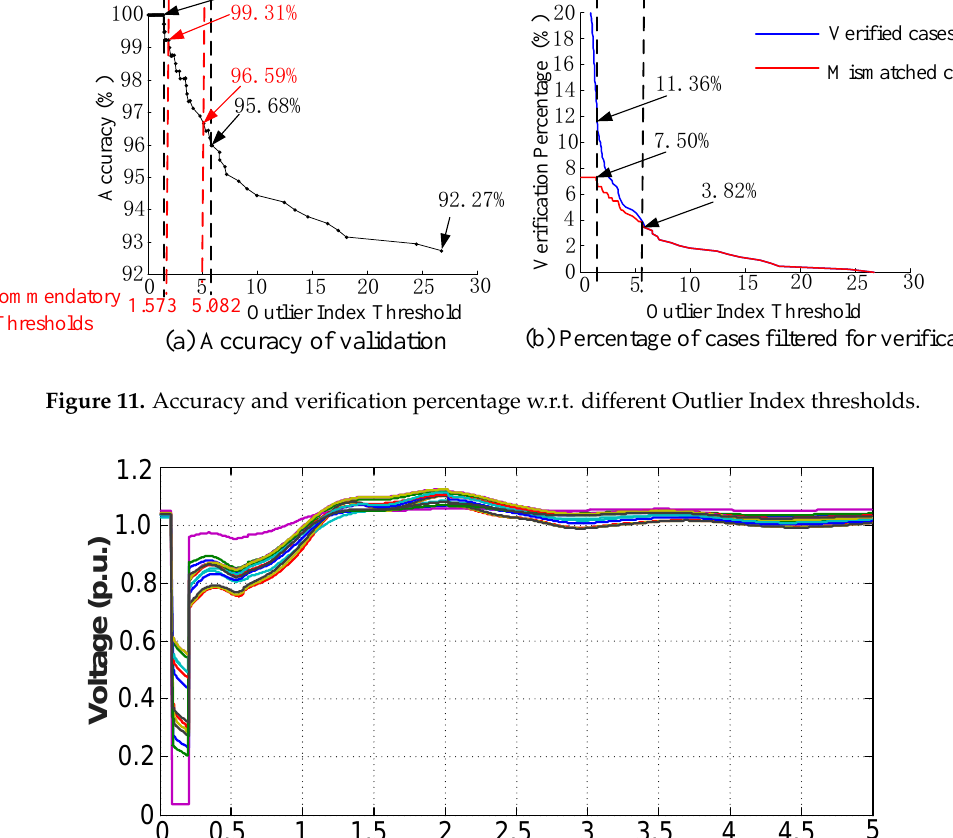
Figure 12. Time-domain simulation of the insecure case with minimum Outlier Index.